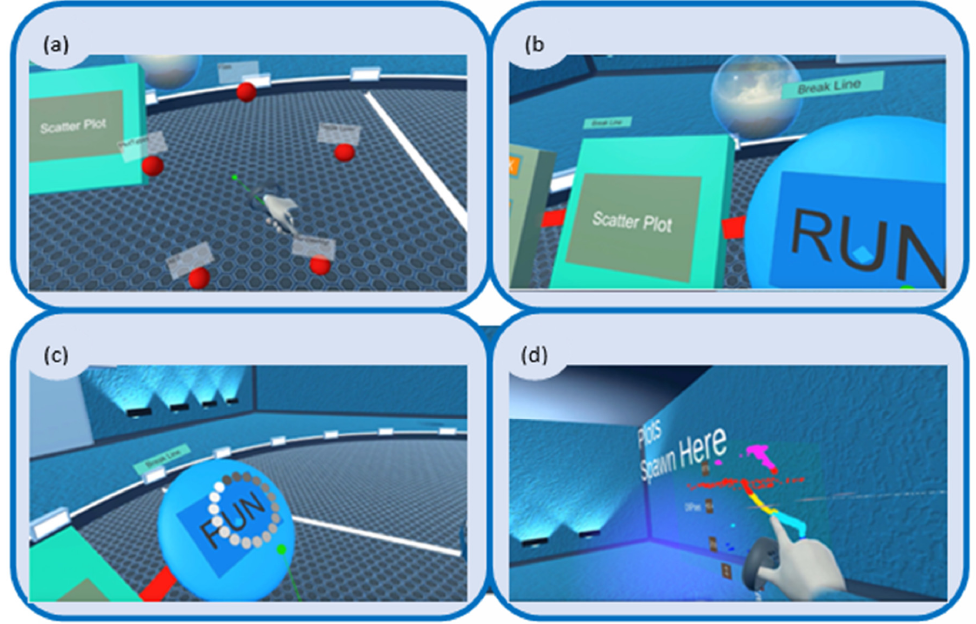
Figure 8. 3D scatterplot generated using IVEE. ( a ) IVEE’s sub menu system to draw a plot. ( b ) Virtual object to run the plot. ( c ) Indication of the progress. ( d ) Three-dimensional scatterplot.